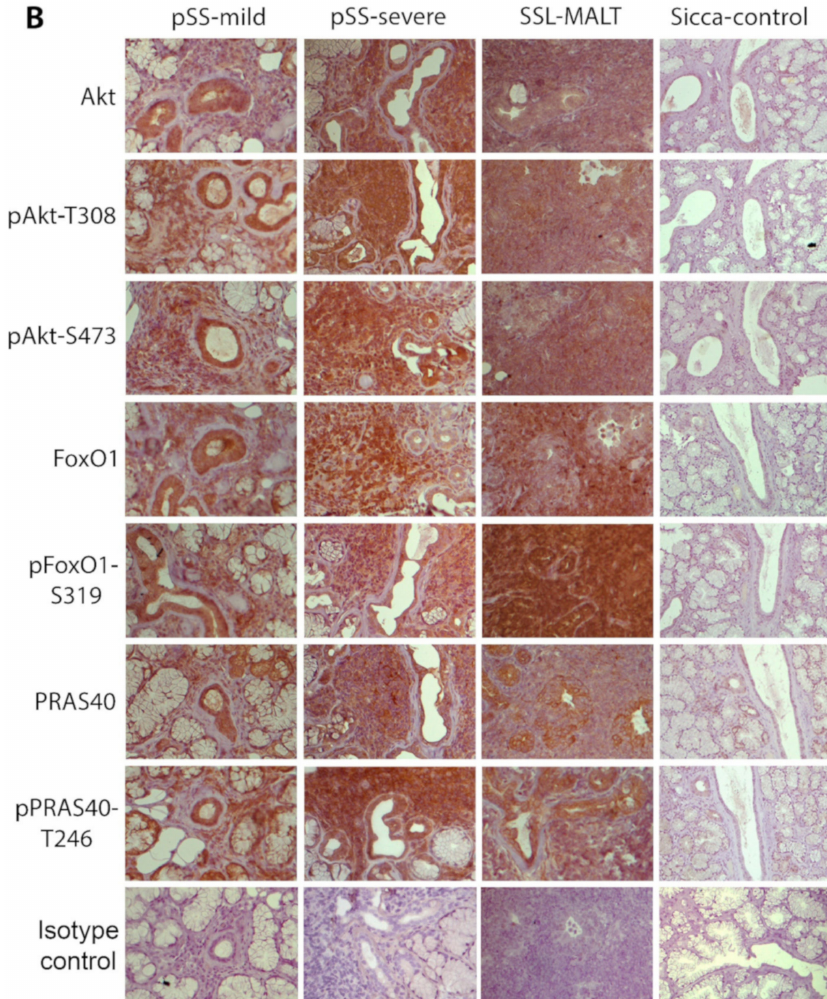
Figure 1. Akt signaling pathway is activated in the MSGs of pSS patients, but not in sicca-complaining controls. ( A ) Representative pictures of the immunohistochemical detection of Akt, phosphoAkt-T308 (pAkt-T308) , phosphoAkt-S473 (pAkt-S473) , FoxO1, phosphoFoxO1-S319 (pFoxO1-S319) , PRAS40, and phosphoPRAS40-T246 (pPRAS40-T246) molecules and isotype control in the MSGs of pSS patients and sicca-complaining controls (sicca-control) , as well as in the stomach of patients with MALT lymphoma associated with H. pylori infection (gastric-MALT) showing strong expression in patients with pSS or gastric MALT, but not in sicca-controls. ( B ) Detail of the pictures of ( A ) representing staining of the indicated molecules in pSS patients and sicca-controls. Similar expression of all the tested molecules was observed among pSS subgroups, including pSS patients without NHL, with mild or severe inflammatory infiltrates in the MSGs ( pSS-mild and pSS-severe, respectively) or with NHL ( SSL ; the figures shown are from an SSL patient with MALT lymphoma, SSL-MALT ). Original objective magnification: ×